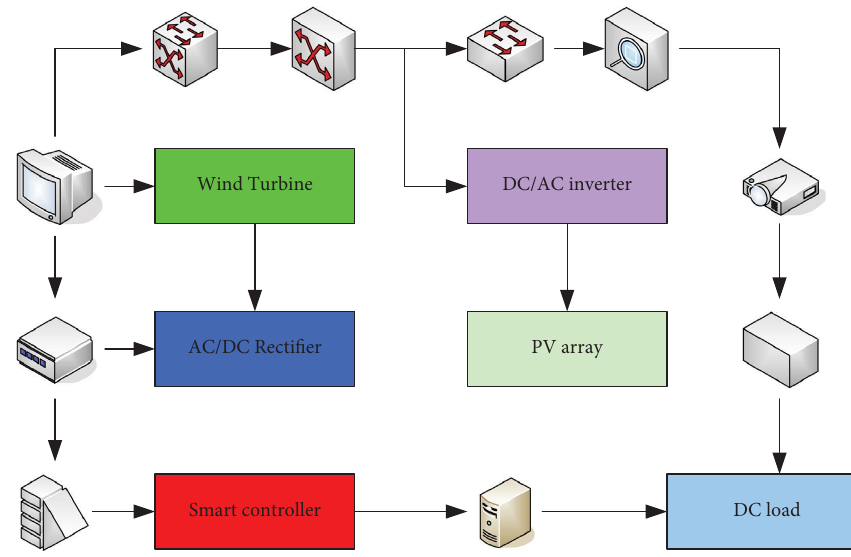
Figure 1: Typical structure of NE hybrid